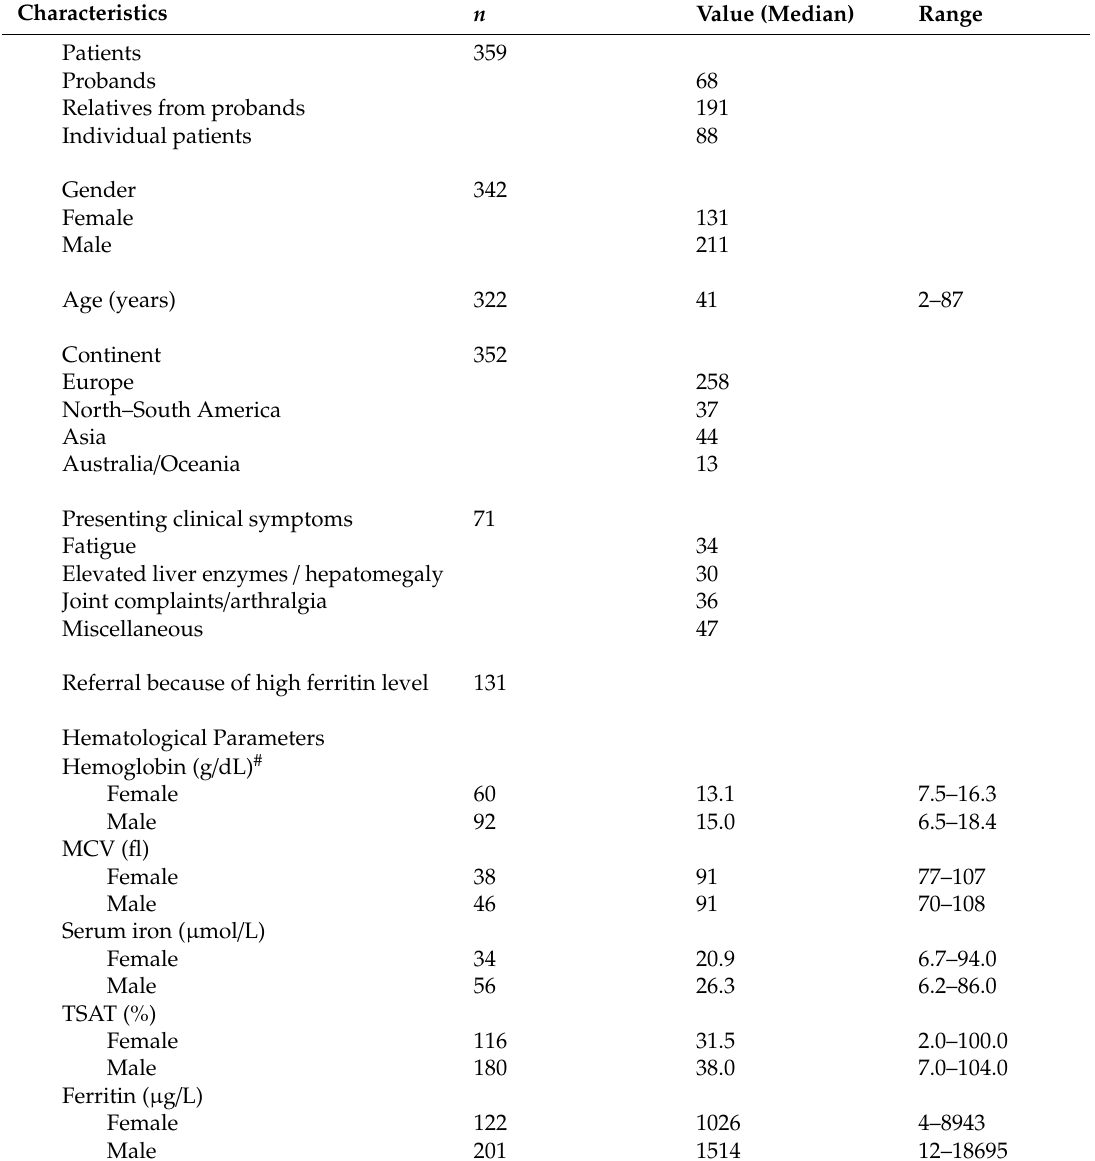
Table 1. Patient Characteristics. MCV: mean corpuscular volume, TSAT: transferrin